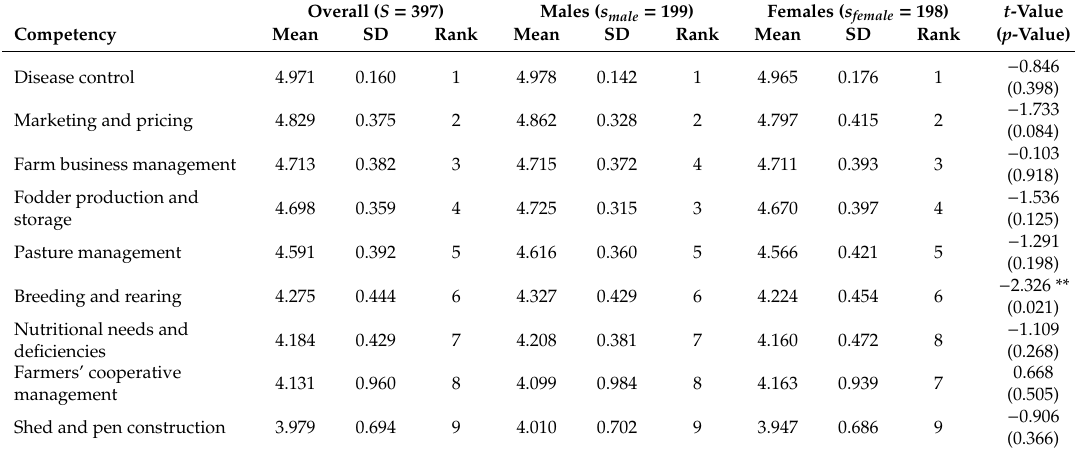
Table 3. Importance of production and management practices among males and females. Overall ( S = 397) Males ( s male = 199) Females ( s female = 198) t -Value Competency Mean SD Rank Mean SD Rank Mean SD Rank ( p -Value) Disease control 4.971 0.160 1 4.978 0.142